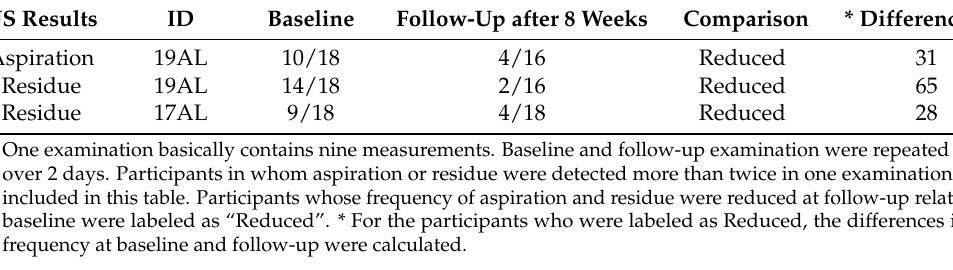
Table 4. Changes in the frequency of aspiration and residue in the control